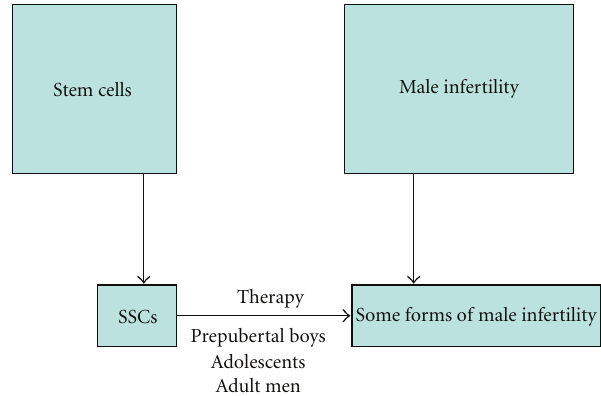
Figure 1: Possible therapeutic application of spermatogonial stem cells